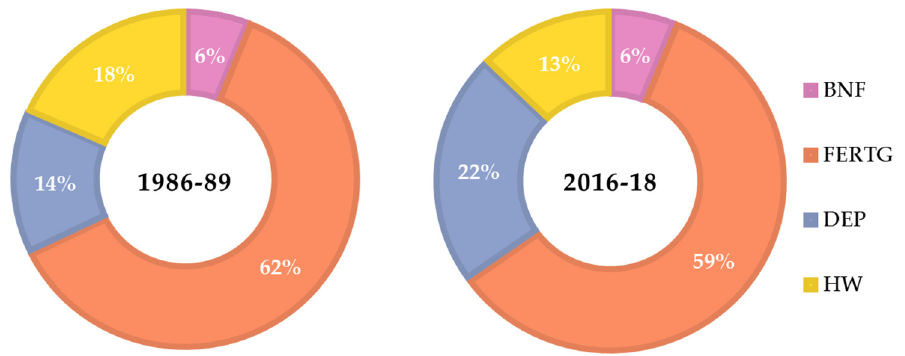
Figure 17. Contribution of the input N terms to the nitrogen surplus in the Low Mondego in periods 1986–1989 and 2016–2018.